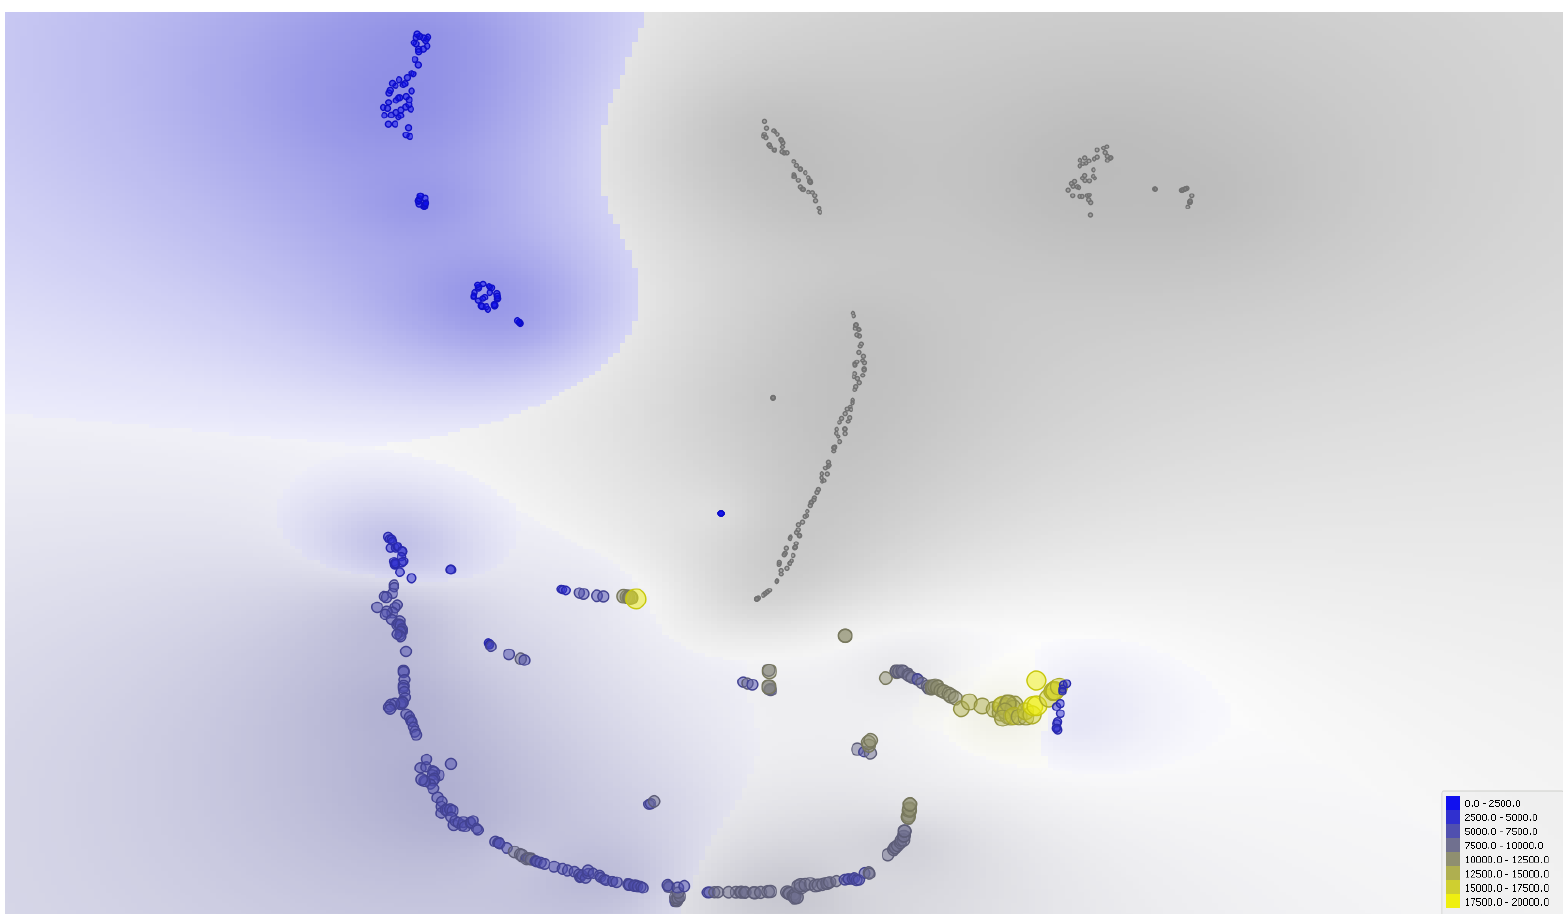
Figure 8. t -distributed stochastic neighbor-embedding projection with respect to the Bitcoin spot price. Note: t -distributed stochastic neighbor embedding is a dimensionality reduction technique, similar to multi-dimensional scaling, where points are mapped to 2D space by their probability